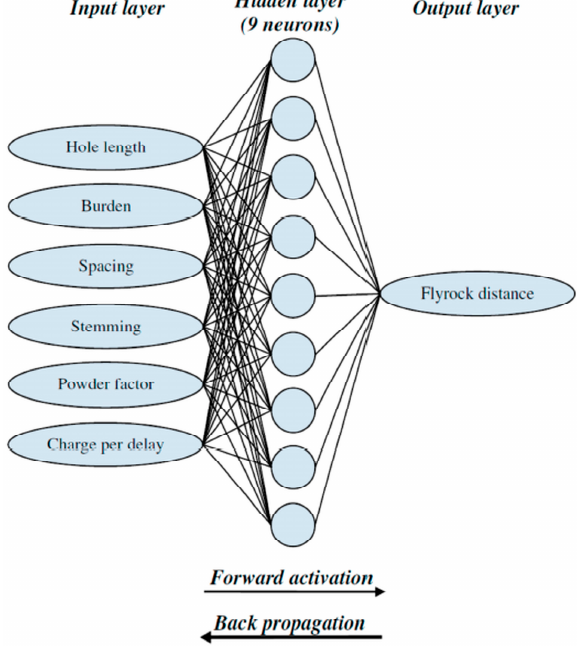
Figure 14. Architecture of artificial neural network in rock blasting (Reprinted from Ref. [93]).